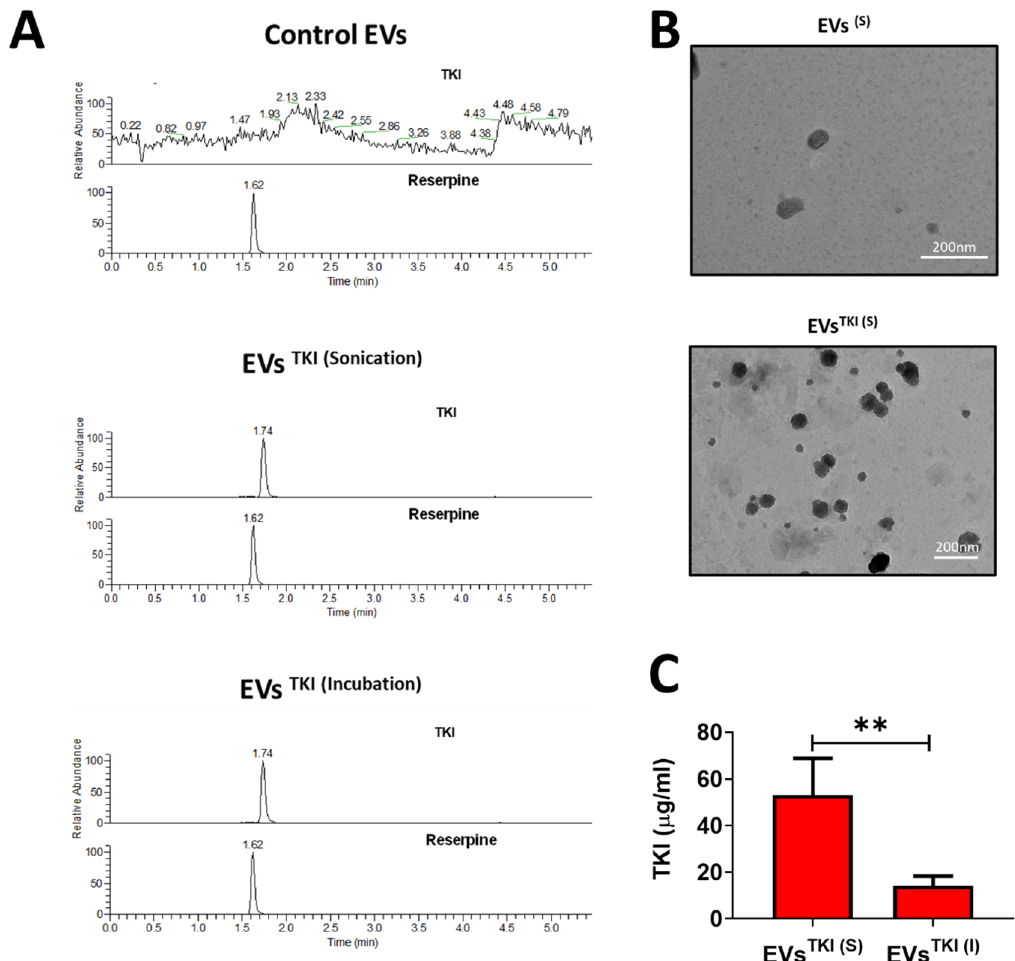
Figure 4. TKI loading into the EVs. ( A ) A representative graphical image of the mass spectrometry chromatogram for the TKI in the EVs, EVs TKI(S) , and EVs TKI(I) . ( B ) Quantifications of TKI in EVs TKI(S) and EVs TKI(I) ( n = 3). The results are expressed as mean ± SD. ( C ) Morphology of the EVs (S) and EVs TKI(S) confirmed by TEM (scale bar: 200 nm). ** p < 0.01 (by Student’s t- test).